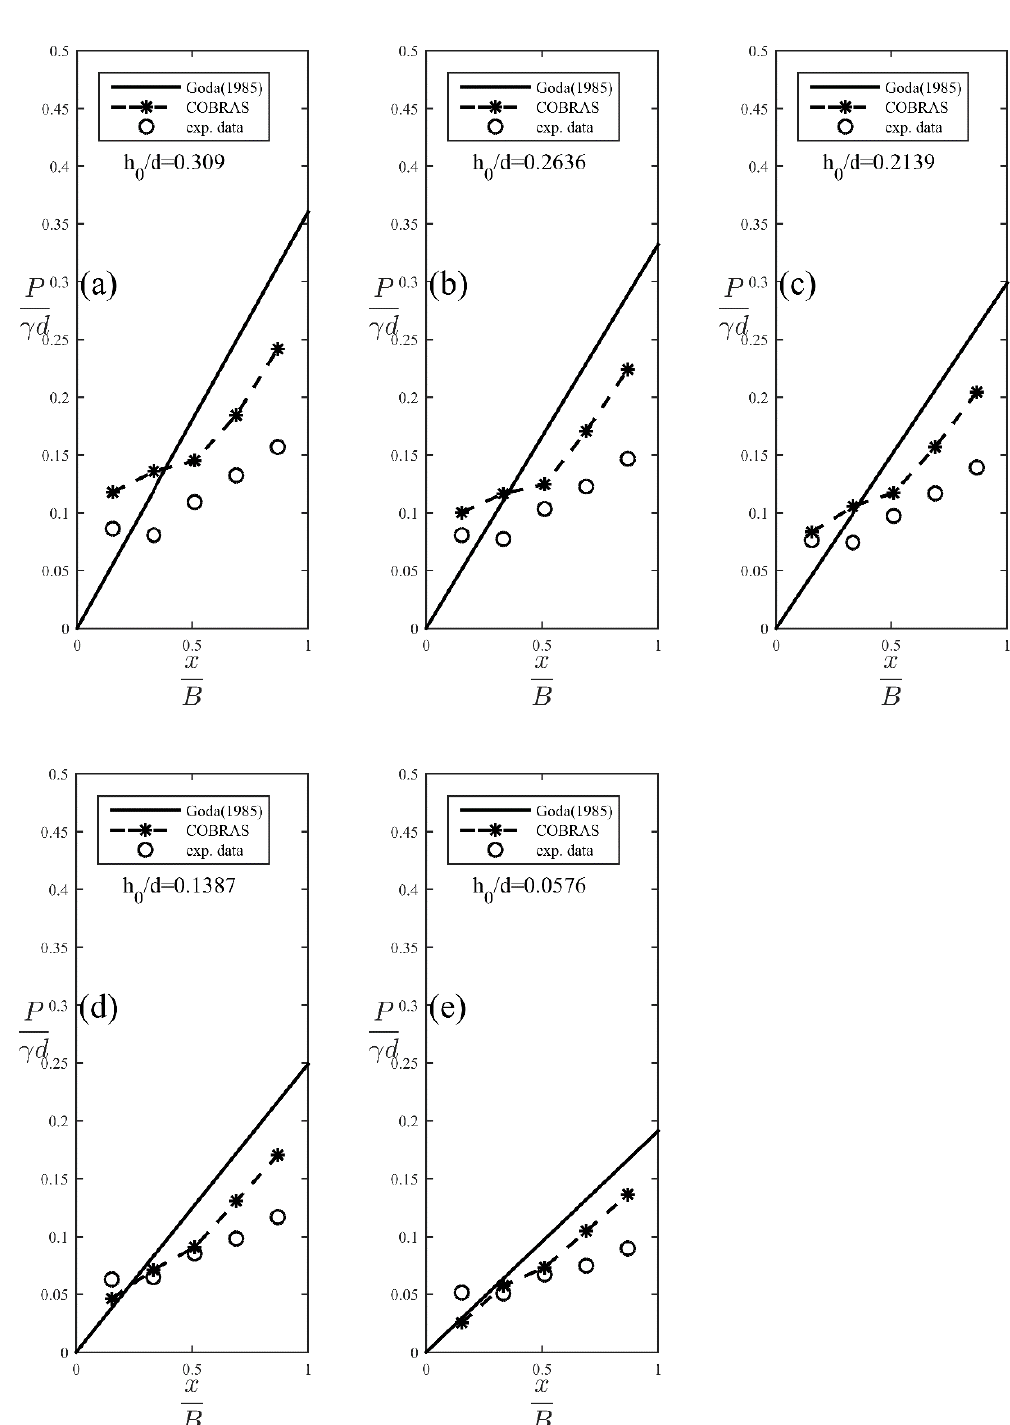
Figure 10. The comparison of maximum wave pressure along the bottom face of caisson as obtained from experiments, numerical simulations, and Goda’s formula [26] for various dimensionless over- topping heights (h 0 /d). ( a ) h 0 /d=0.309; ( b ) h 0 /d=0.2636; ( c ) h 0 /d=0.2139; ( d ) h 0 /d=0.1387; ( e ) h 0 /d=0.0576..